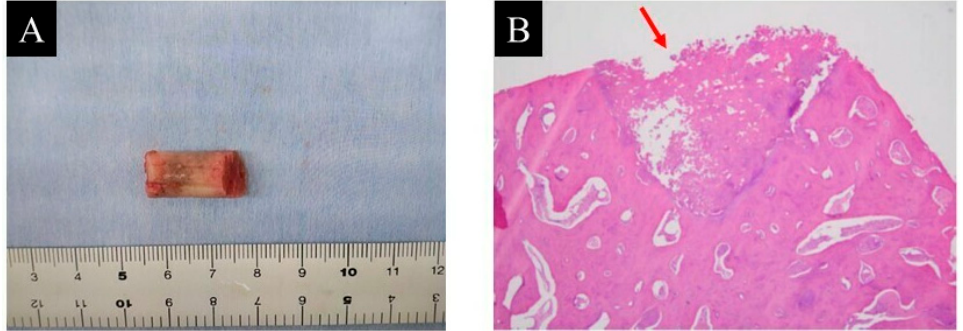
Figure 4. ( A ) resected specimen and ( B ) pathological examination (hematoxylin and eosin staining; magnification ×20).